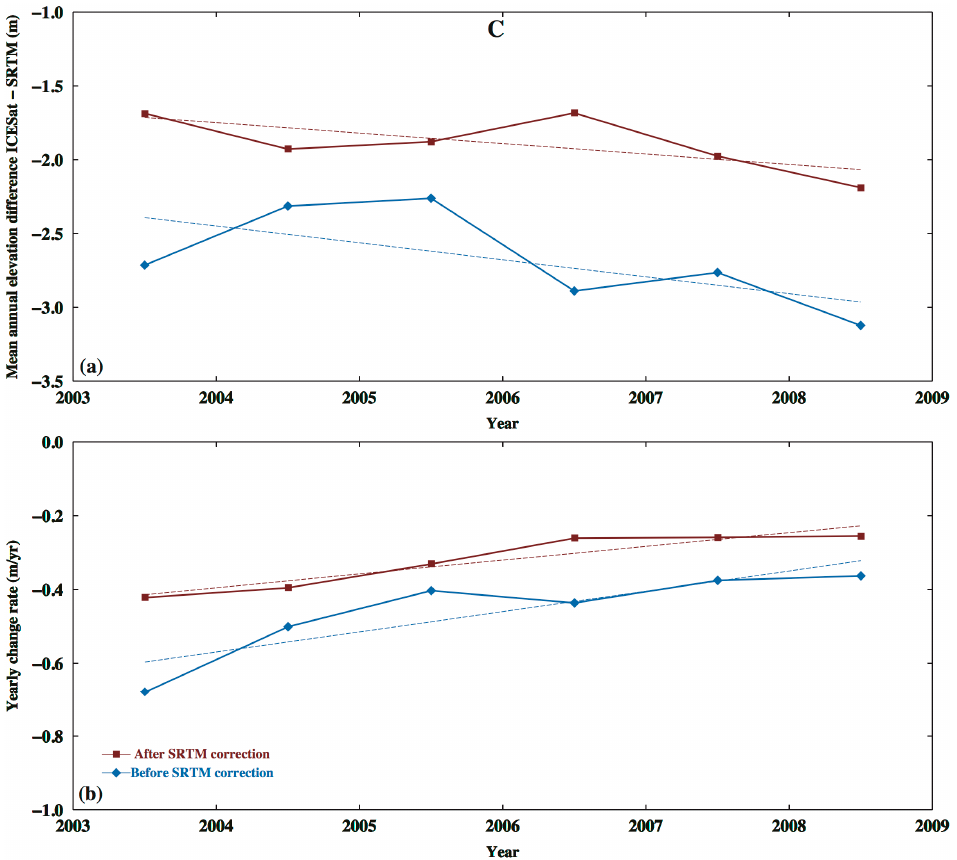
Figure 6. ( a ) Time series of yearly glacier elevation changes from the differences between ICESat and SRTM-derived heights in Region C; ( b ) yearly rates of glacier elevation changes in different years from Equation (6) (change is marked at the mean time of a year) in Region C.